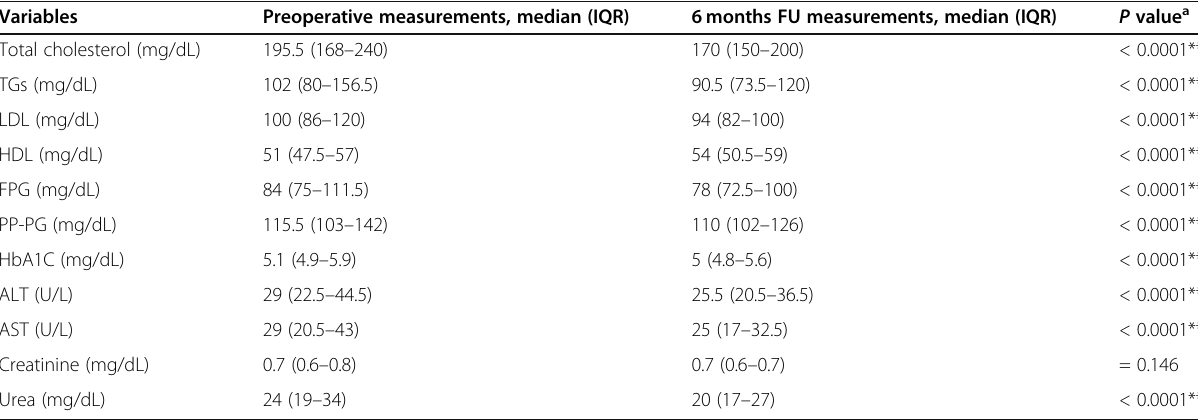
Table 2 Laboratory workup preoperative and 6 months after bariatric surgery